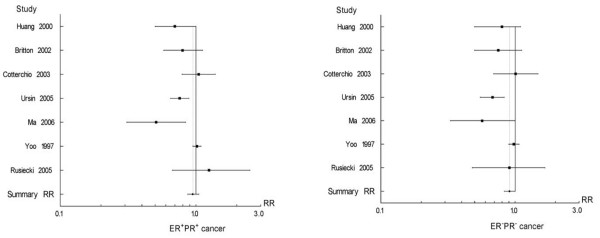
Breastfeeding and breast cancer risk by estrogen receptor/progesterone receptor (ER/PR) status: relative risk (RR) with corresponding 95% confidence interval for highest versus lowest breastfeeding category.